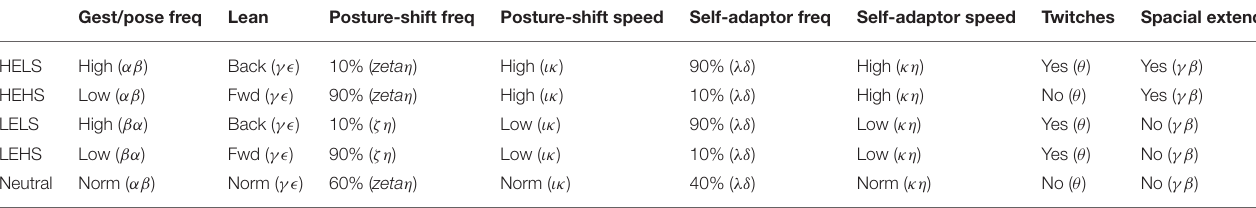
TABLE 4 | Relationship between personality, and gesture and pose behaviour. Gest/pose